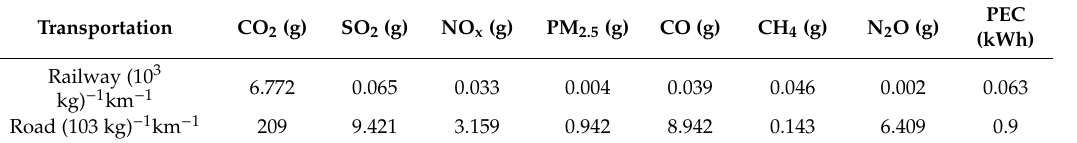
Table 11. The pollutant and PEC of di ff erent transportation methods.